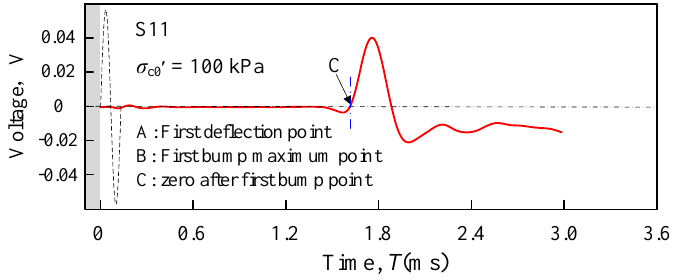
Figure 3. Shear wave signals in specimen for case ID: S11. Table 3. Schemes of bender element tests for Nantong marine silty sand.